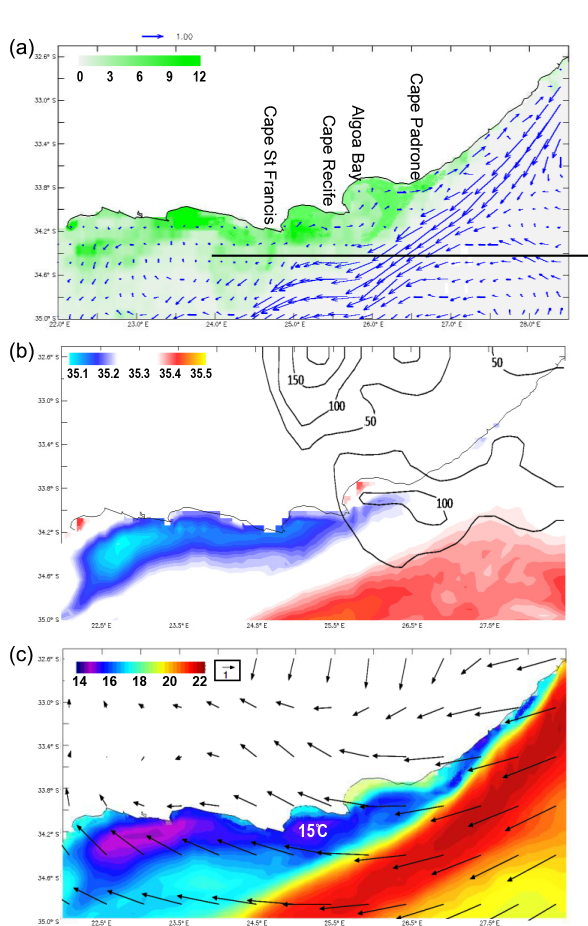
Figure A1. Case study productivity event for 24 October–8 Novem- ber 2009: (a) MODIS chlorophyll (mgm − 3 ) and HYCOM currents at 10m depth (vector), (b) HYCOM salinity at 10m depth and cu- mulative CMORPH rainfall >50mm (contour), (c) SST map and MERRA2 surface winds (vector). Easterly flow, inshore upwelling, and high rainfall characterize this event. Thin west–east line in (a) refers to the 34.5 ◦ S section for Fig. A2 below.